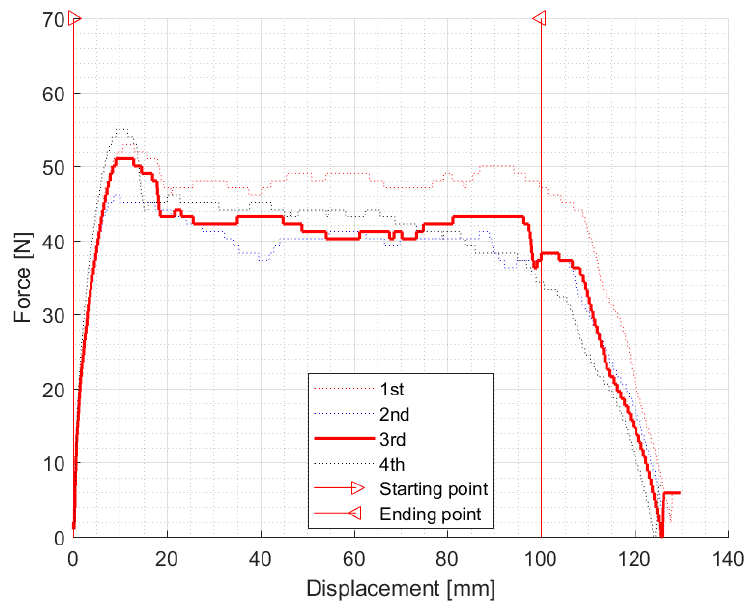
Figure 11. Representative values of the bonding force test results and experimental data (data of third